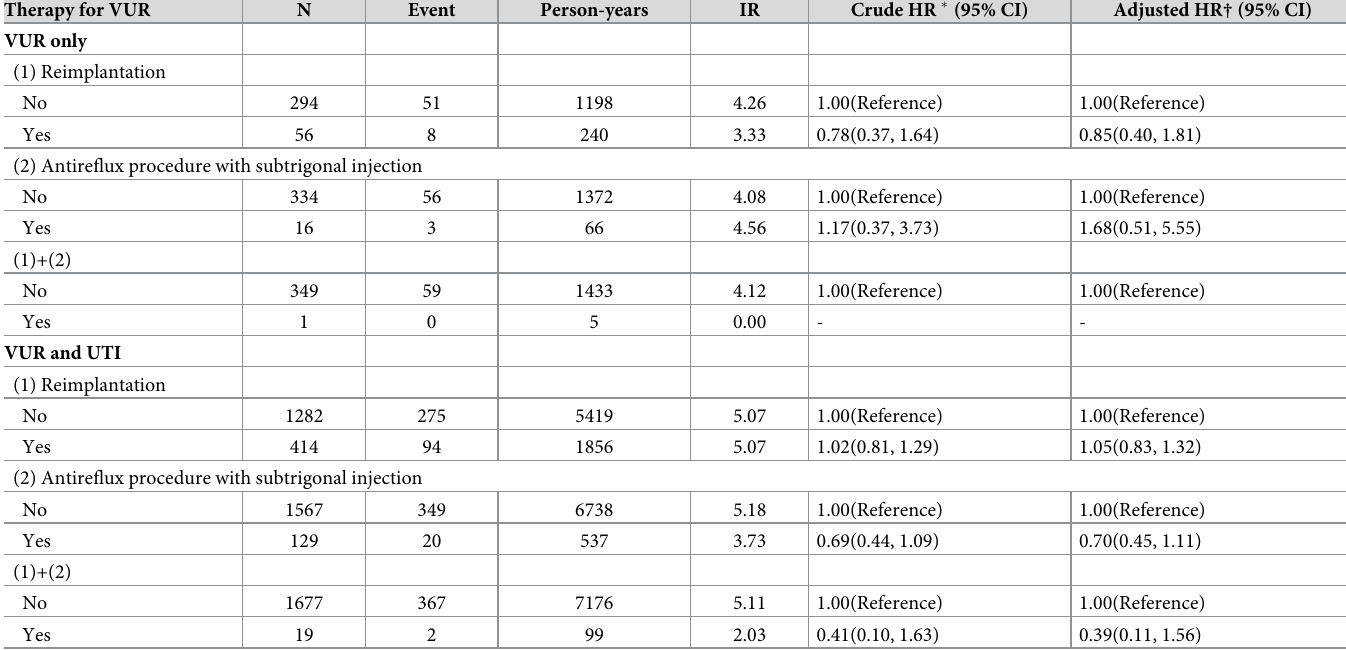
Table 4. Incidence, crude and adjusted hazard ratio of asthma among children with vesicoureteral reflux (VUR) stratified by specific treatments for VUR in Cox proportional hazard regression. Therapy for VUR